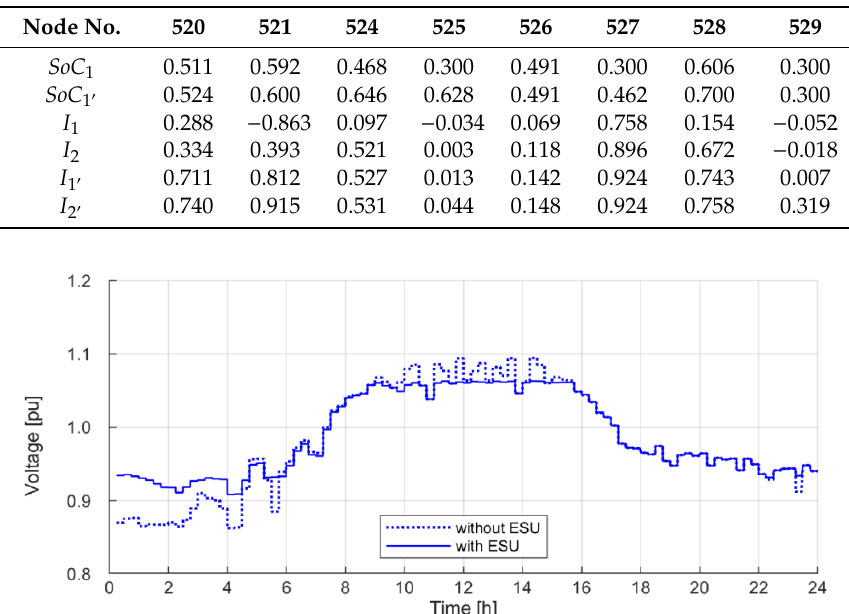
Table 5. Controllers parameters for individual ESU (load profile B).